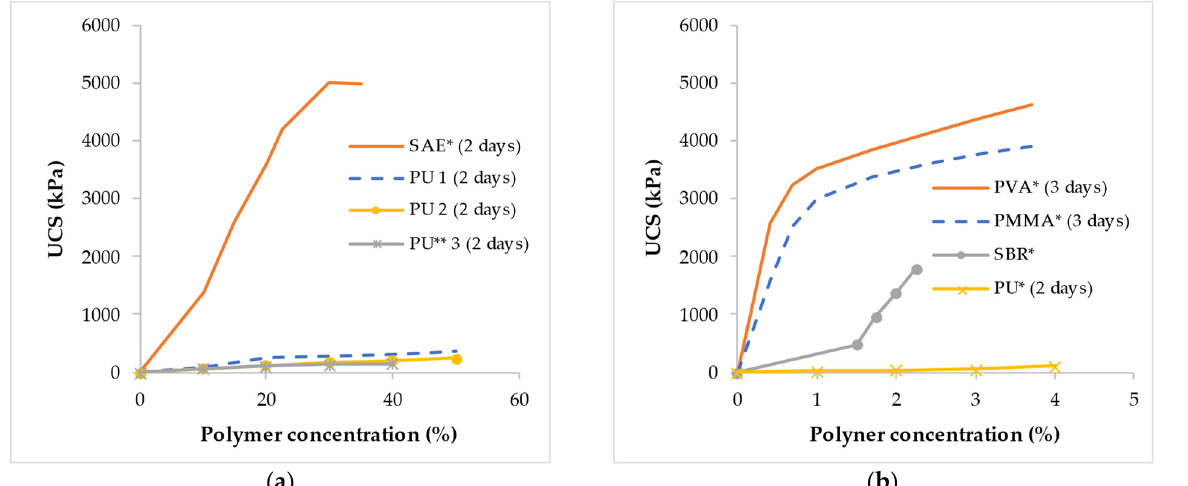
Figure 6. Influence of polymer treatment on the UCS of sand applied at: ( a ) High polymer concen- tration; ( b ) Low polymer concentration (* indicates polymer concentration as a % of dry weight of soil and ** as a % of weight of water). Note: these figures were created with data obtained from [114,116,124,128,130,160,161].